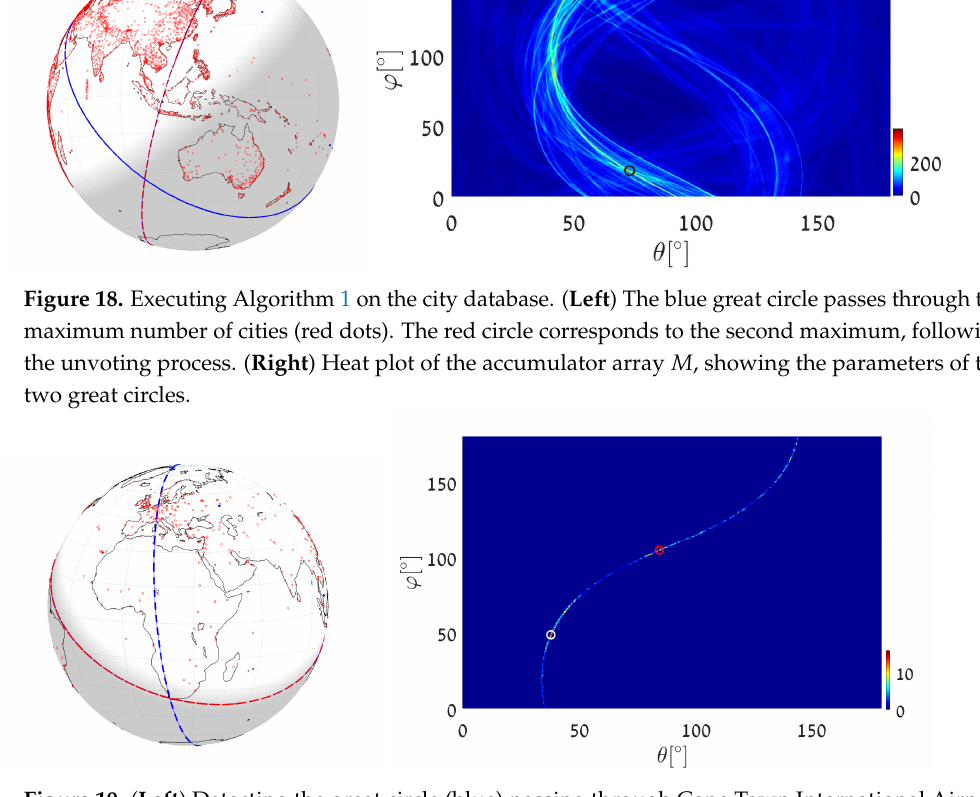
Figure 19. ( Left ) Detecting the great circle (blue) passing through Cape Town International Airport and through the maximum number of other airports, using uniform quantization in the plane. The red circle corresponds to the second maximum, following the unvoting process. ( Right ) Heat plot of the accumulator array M along the θ ( ϕ ) curve corresponding to Cape Town airport, showing the parameters of the two great